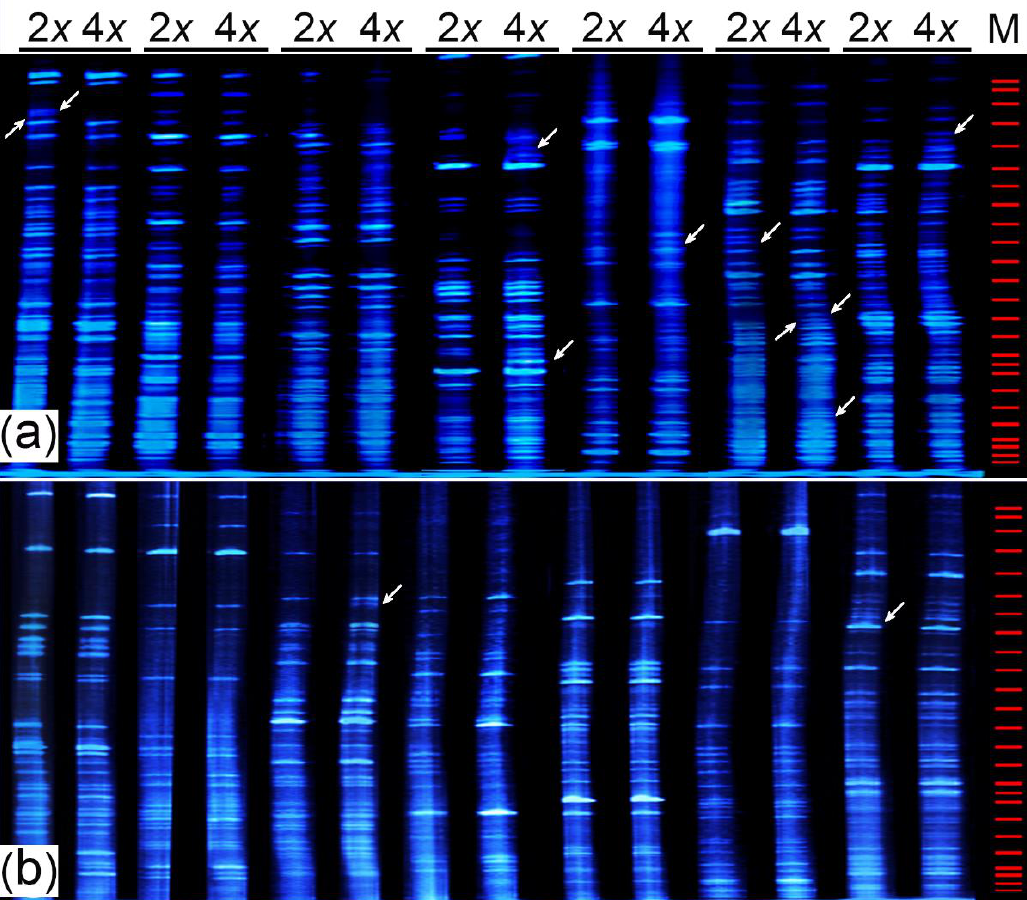
Figure 7. SSAP profiles of diploid and tetraploid (T1) species of C. nankingense . The LTR-specific primers were designed from CnMp1 ( a ) and CnMp2 ( b ).